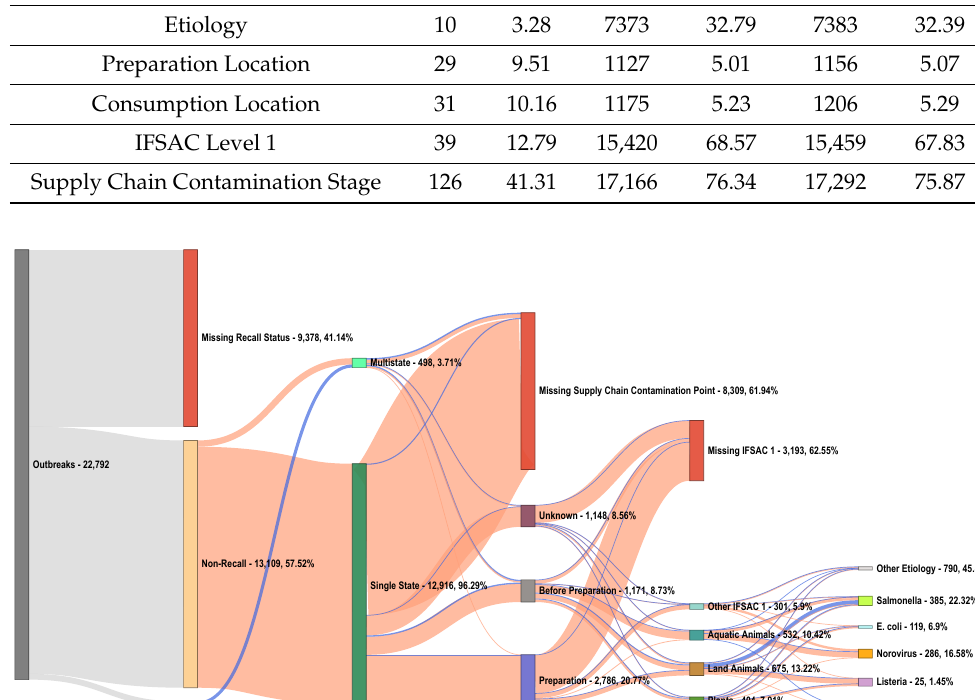
Figure 3. A Sankey Diagram of the distribution of recalls and non-recalls with and without missing information across all risk factors examined by using Model 6. We report frequencies and percentages of foodborne and waterborne outbreaks associated with each risk factor for all 22,792 outbreaks reported by the electronic Foodborne Outbreak Reporting System (eFORS) and National Outbreak Reporting System (NORS) in 1998–2019. Blue and orange colors define recalls and non-recalls, re- spectively. Outbreaks with missing recall status or risk-factor information are defined with orange terminal nodes. We calculated percentages according to the frequency of observations available for each risk factor, which include recall status, single- or multistate exposure outbreak, supply chain contamination stage, Interagency Food Safety Analytics Collaboration (IFSAC) Level 1 food categorization, and etiology of contaminant. Other IFSAC 1 includes outbreaks associated with Other ( n = 36), Unclassifiable ( n = 33), Undetermined ( n = 229), and Invalid ( n = 3) food products. For con- taminant etiology, we list the 5 etiologies of interest in our study ( Salmonella , E. coli , norovirus, Listeria , and scombroid poisoning), as well as Other Etiology to account for contaminants not considered in our